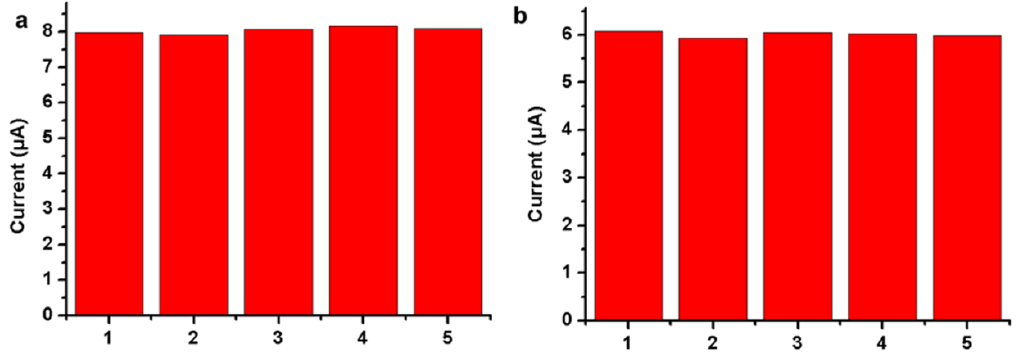
Figure 5. Determination of reproducibility of developed GOx/N-doped CDs/chitosan modified GCE in air-saturated PBS containing 10% of serum sample with: ( a ) 1 mM and ( b ) 5 mM glucose.